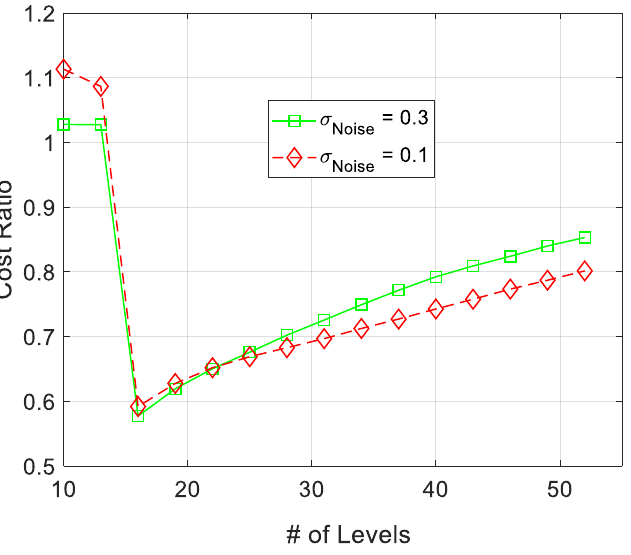
Figure 7. Comparison between the spatial modeling cost of AWSG and SSG. The relative cost R = Cost SSG ( k ) / Cost AWSG ( k ) is sketched for two different filtered noise strength in sensor observations. Spatial Tracking Cost: